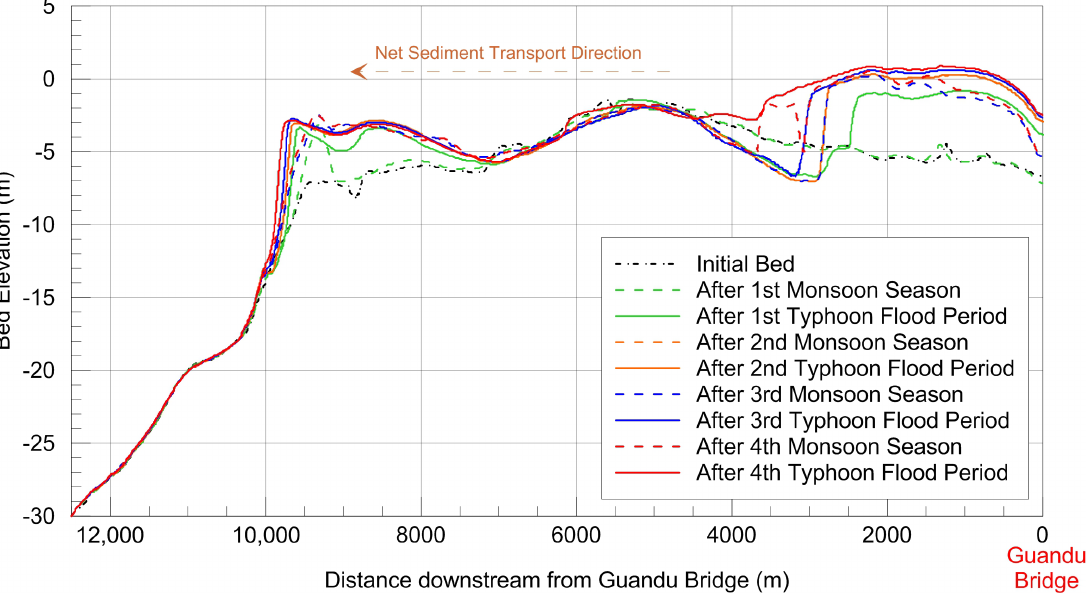
Figure 14. Profiles of bed elevations from the Guandu Bridge to 2500 m out to sea from the estuary (dotted line A–A’ in Figure 11a).